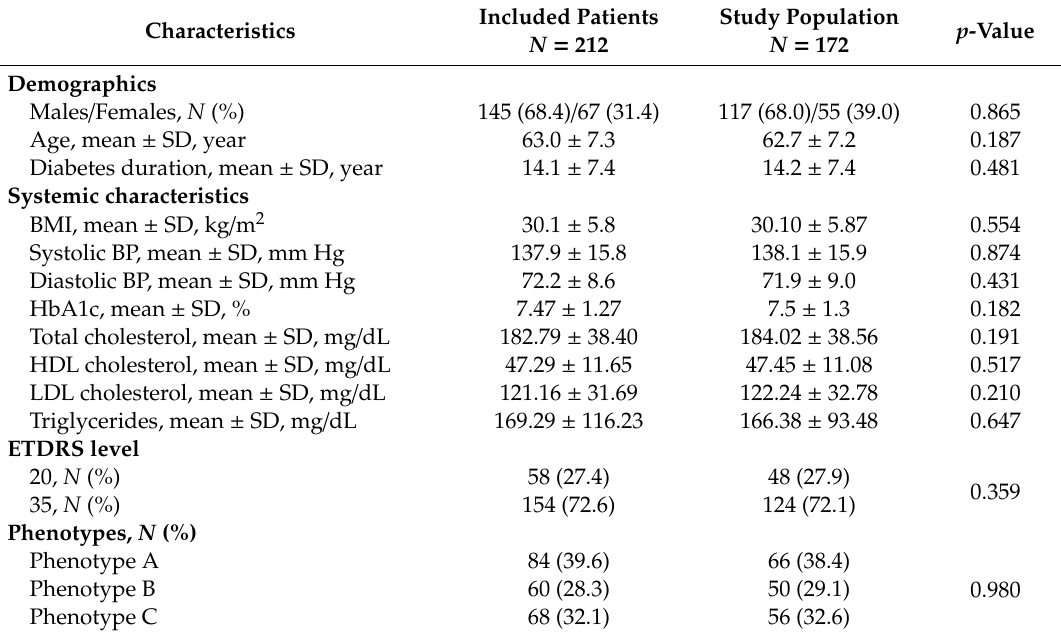
Table 1. Demographic and clinical